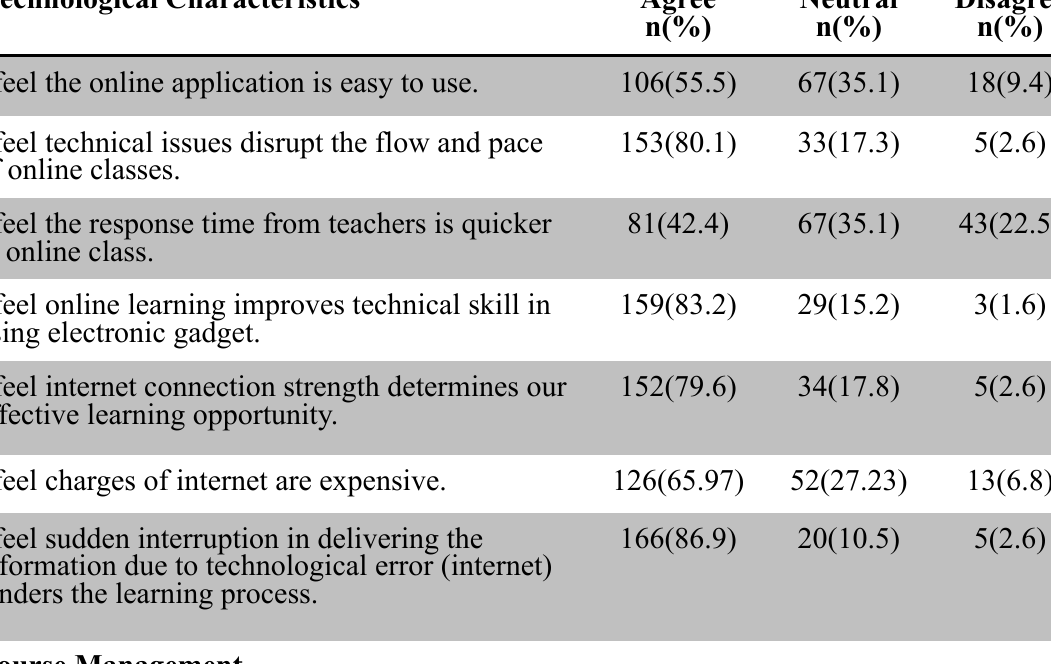
Table 2: Participants' Responses regarding Technological and Course Management (n=191) Technological Characteristics